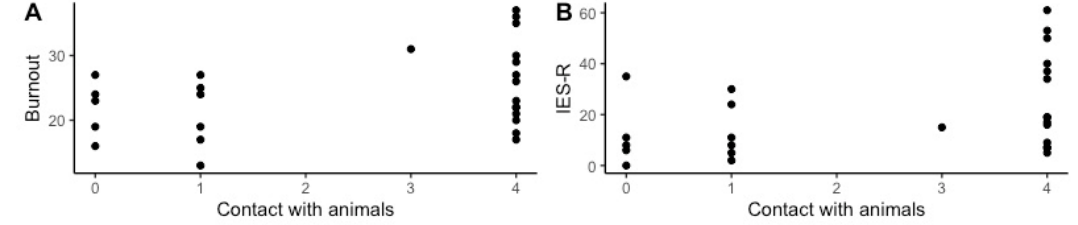
Figure 2. The significant di ff erences in Burnout ( A ) and IES-R ( B ) by contact with animals. Possible burnout scores ranged from 10 to 50 and possible IES-R scores ranged from 0 to 88. Greater contact with animals predicted lower burnout (F (1) = 12.408, p = 0.003) and higher IES-R scores (F (1) = 10.012, p = 0.005). IES-R: Impact of Event Scale-Revised.